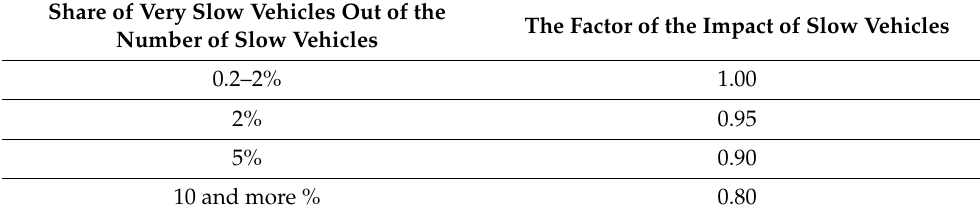
Table 6. The factor of the impact of very slow vehicles k b [65]. Share of Very Slow Vehicles Out of